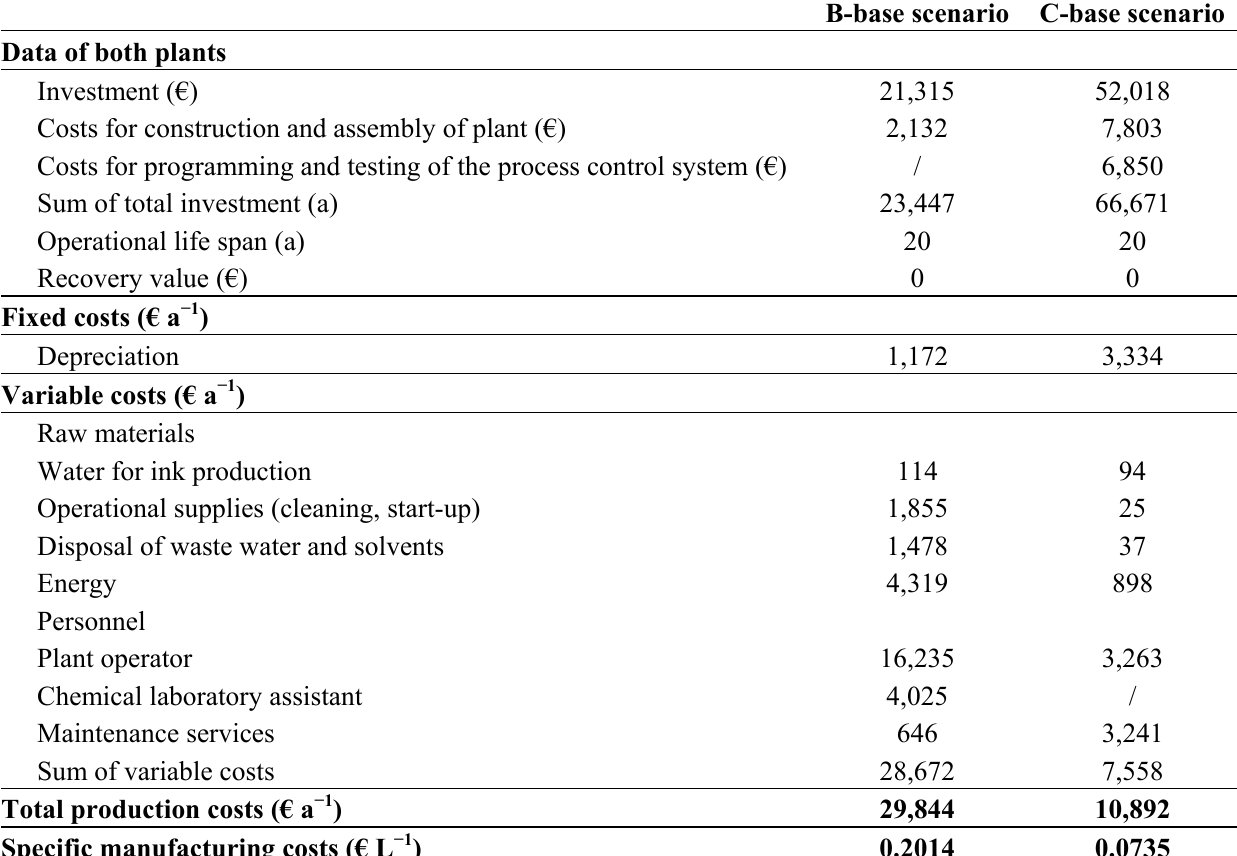
Table 3. Total annual production costs of the base scenarios of the batch production (B base scenario) and the micro-/milli-continuous campaign manufacturing scheme (C base scenario) for a total production output of 148,200 L of writing